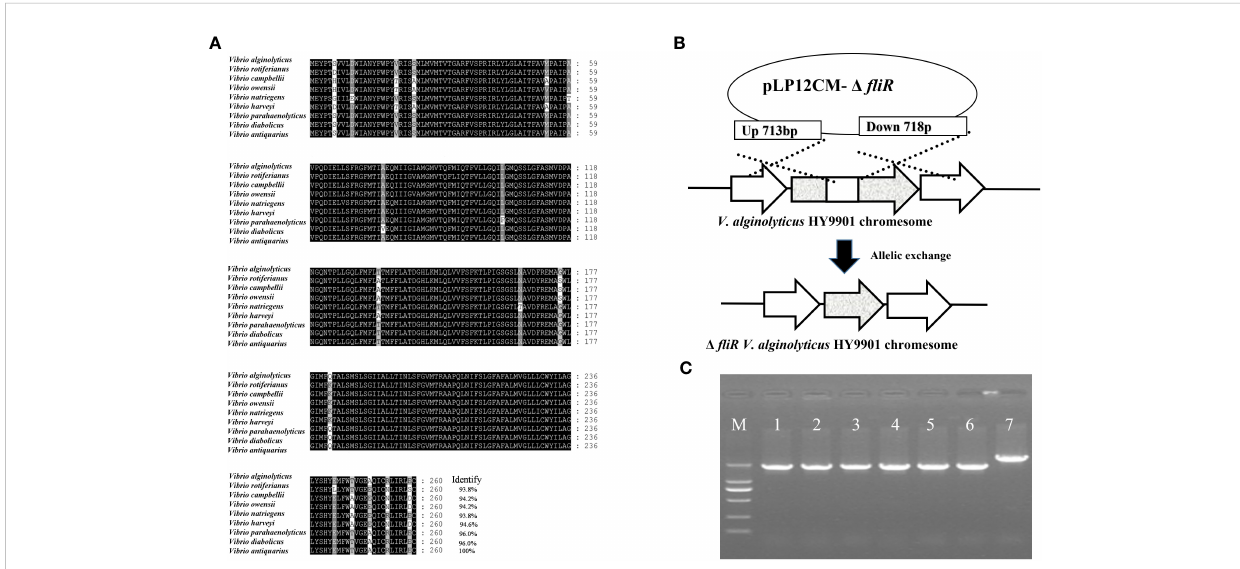
FIGURE 1 Identi fi cation of fl iR gene from V. alginolyticus HY9901 strain and construction of fl iR mutant strain. Multiple alignments of the fl iR amino acid sequences of V. alginolyticus HY9901 with other Vibrio species (A) . The fl iR gene of V. alginolyticus HY9901 was knocked out by allele exchange (B) . PCR ampli fi cation of wild-type V. alginolyticus HY9901 (lane 6), fl iR mutant strain (lanes 1-5). Lane M is a 1 kb ladder. The PCR product of the mutant strain is smaller than that of wild-type V. alginolyticus HY9901 due to the partial deletion of the corresponding gene. The construction of the deletion strain was con fi rmed by PCR ampli fi cation (C)